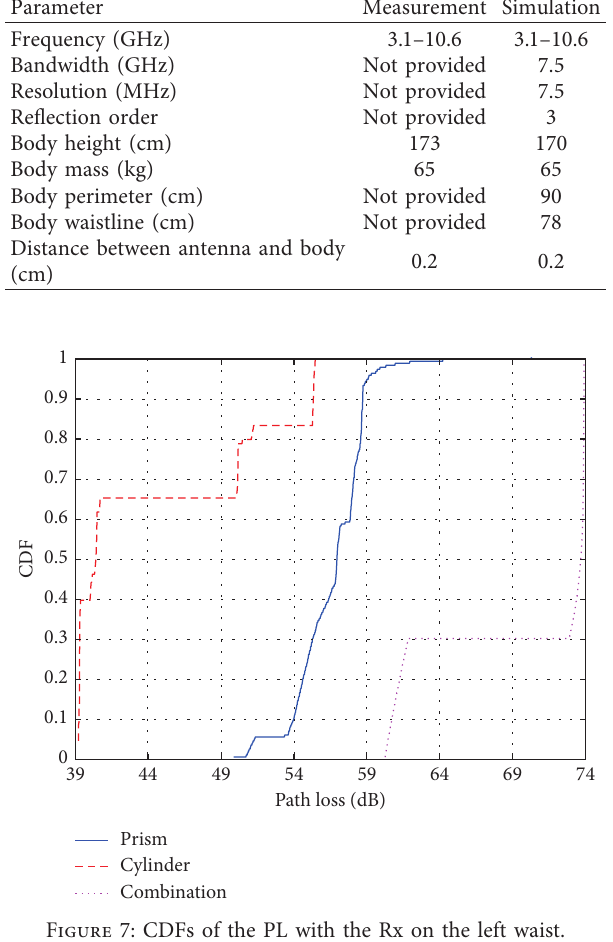
Figure 7: CDFs of the PL with the Rx on the left waist.